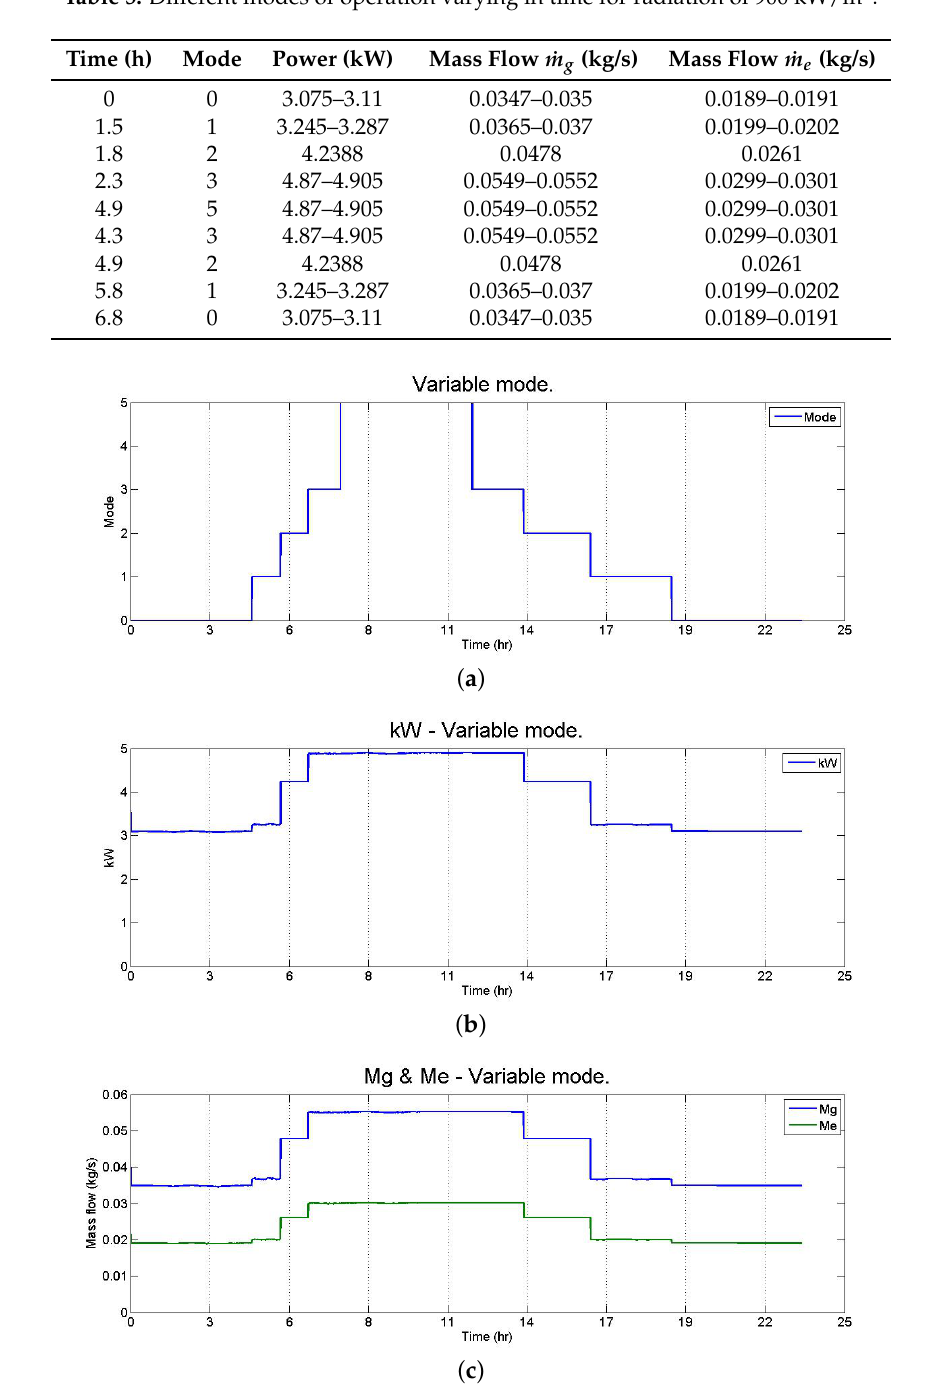
Figure 17. Behavior of the variable mode of use of the cooling system defined by the end user. ( a ) Variable mode used. ( b ) kW of variable mode. ( c ) Mass flow for the generator and